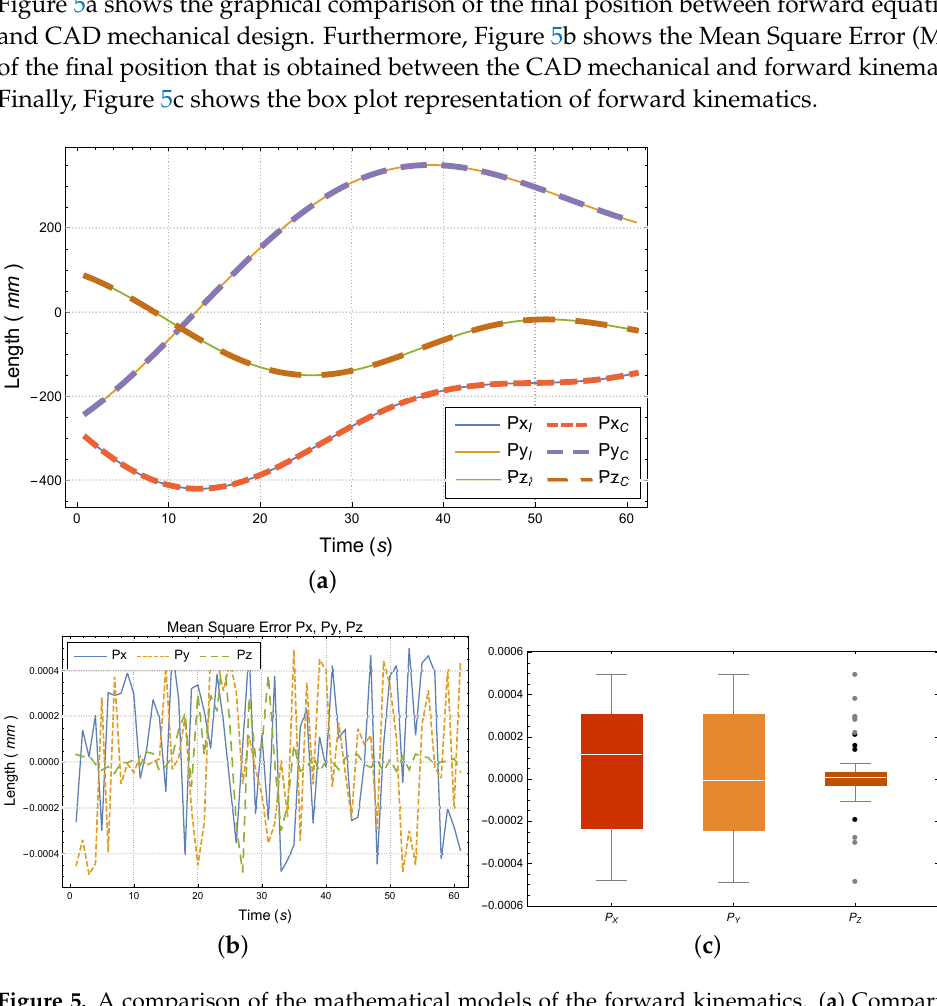
Figure 5. A comparison of the mathematical models of the forward kinematics. ( a ) Comparison of the position ( P X , P Y , P Z ) between CAD mechanical design and forward kinematics equations. ( b ) Mean Square Error of the forward kinematics. ( c ) Box plot of the forward